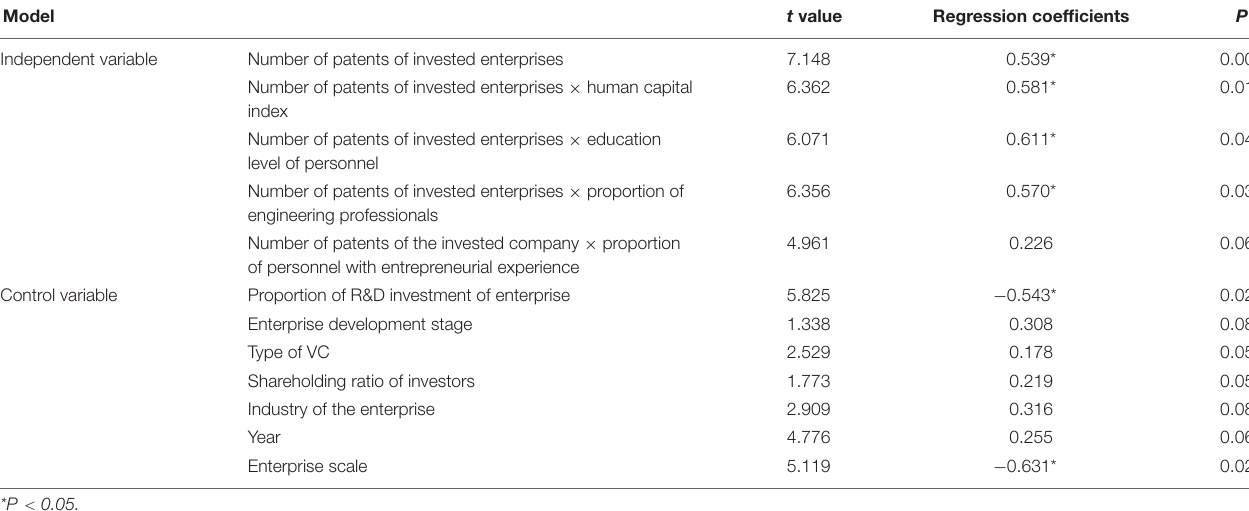
TABLE 6 | The role of human-capital VC in transforming enterprise’s innovation ability into enterprise’s benefit (return on equity). Model